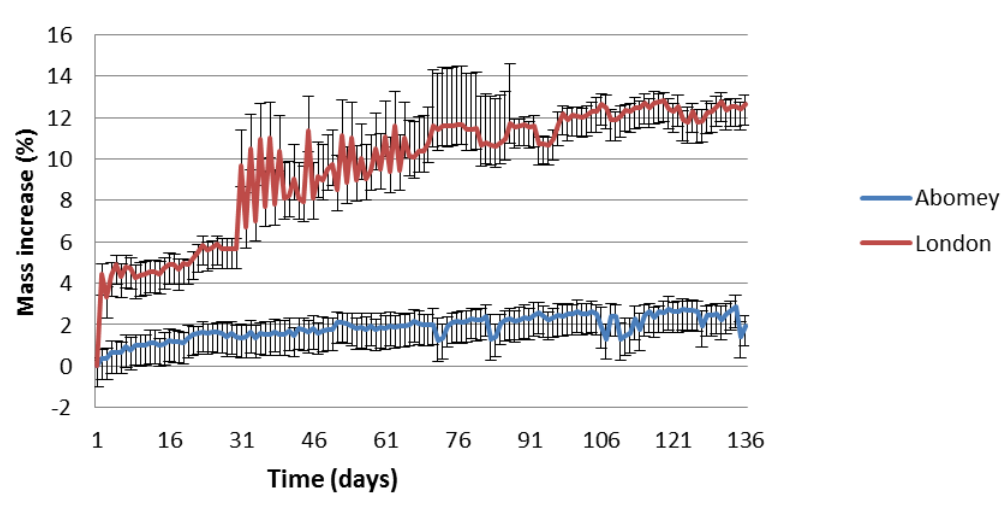
Figure 9. Daily averaged percentage of mass increaseof 50-nm Cu sensors in Abomey and London during a period of 140 days of exposure between November 2012 and April 2013 with standard deviations as error